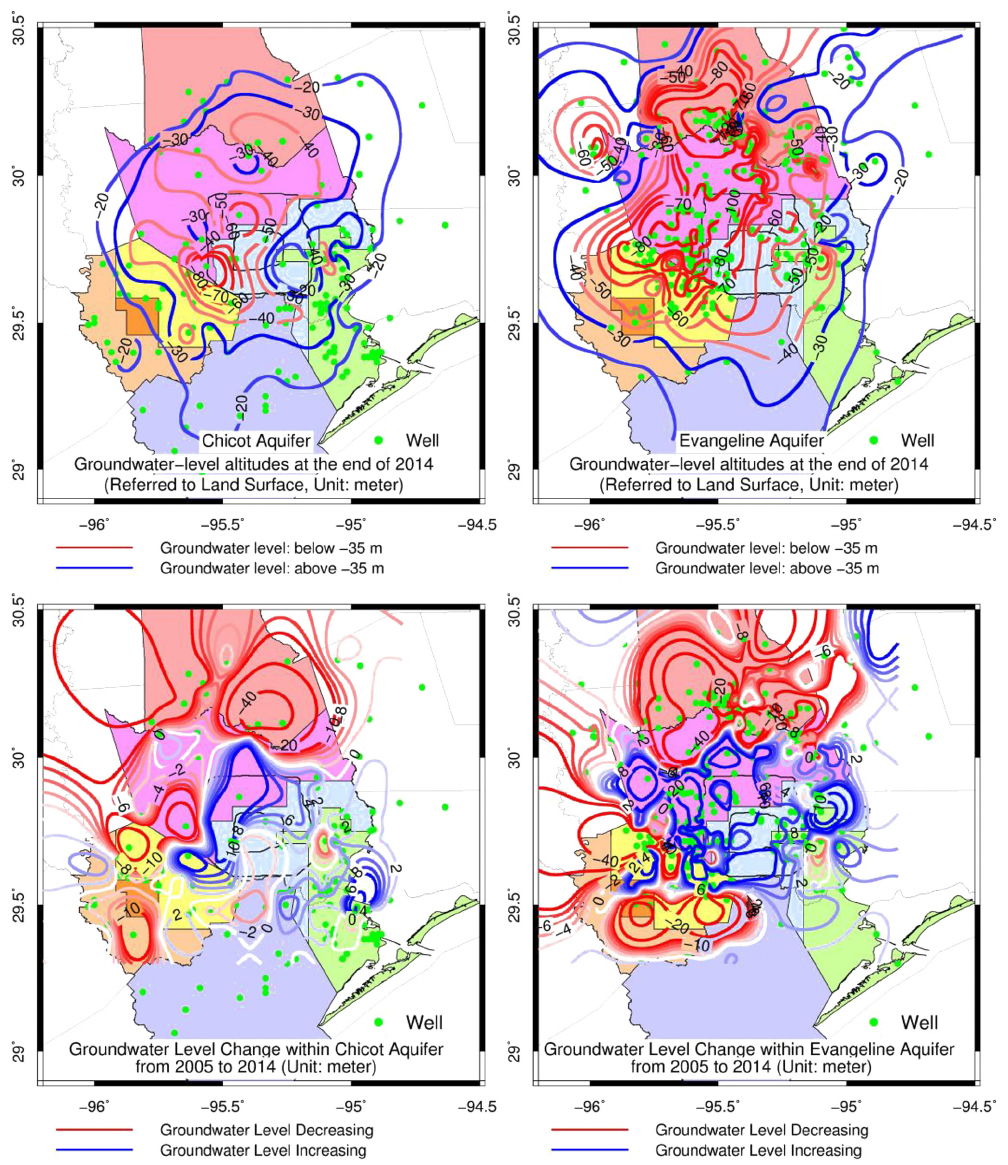
Figure 4. Contour maps showing groundwater-level altitudes within the Chicot and Evangeline aquifers at the end of 2014 and the changes of groundwater-level altitudes from 2005 to 2014. The colored areas represent the groundwater regulation zones as shown in Fig. 3.